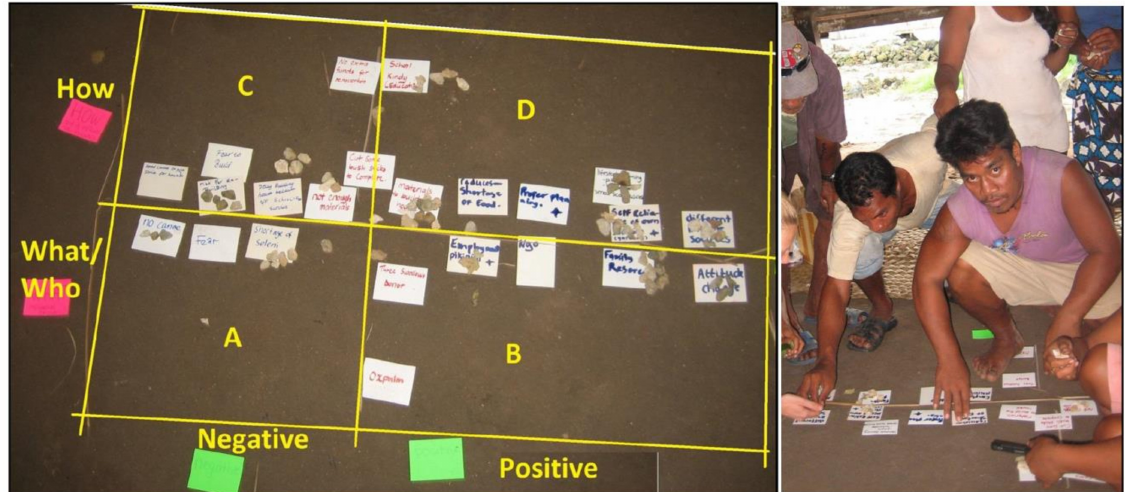
Figure 8. Results of a cause and-effect participatory exercise in Nusa Baruka. The piles of stones indicate the value and level of importance of identified cause and effect (such as loss of water supply). These exercises are examples of the general approach to research for this project, since they facilitated mechanisms for communication and analytical thinking, co-designed by the community and the researchers. The use of local materials is important in this work as they are readily available and carry with them a ‘loc-l credibility’, increasing a sense of community ownership in the research process.